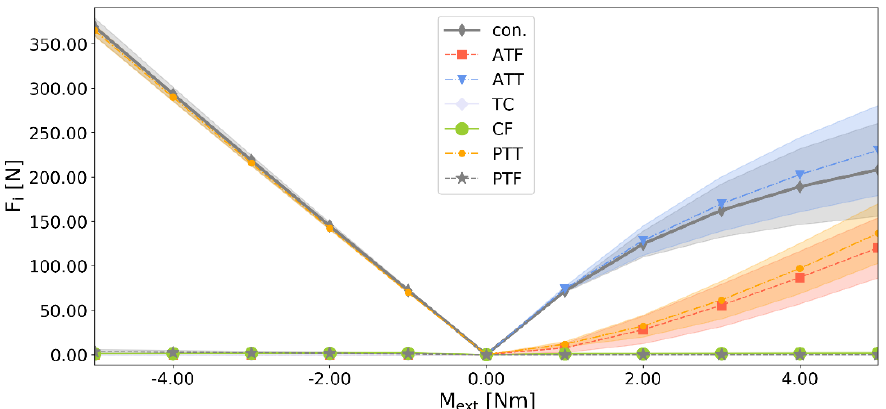
Figure 8. Values of the forces generated by the ligaments versus the external moment M ext for the two most different adversarial structures A and B , where: ‘con.’ is the magnitude of the contact force.